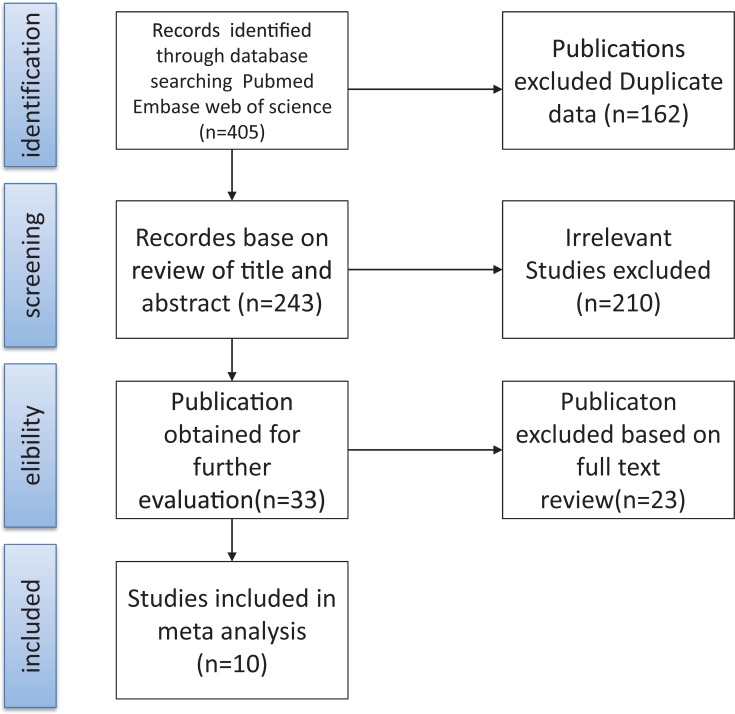
Flowchart for obtaining data for the present meta-analysis.